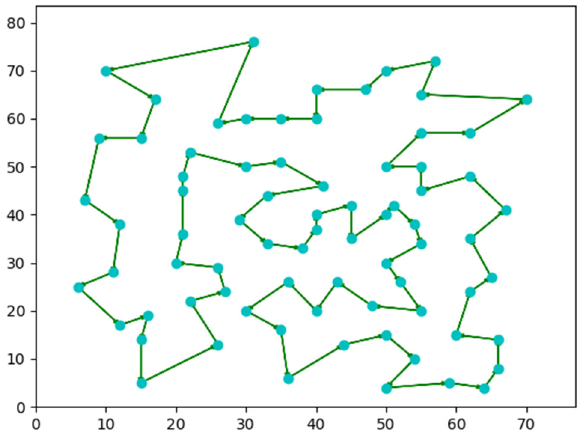
Figure 17. DTLBO solution for Eil76.